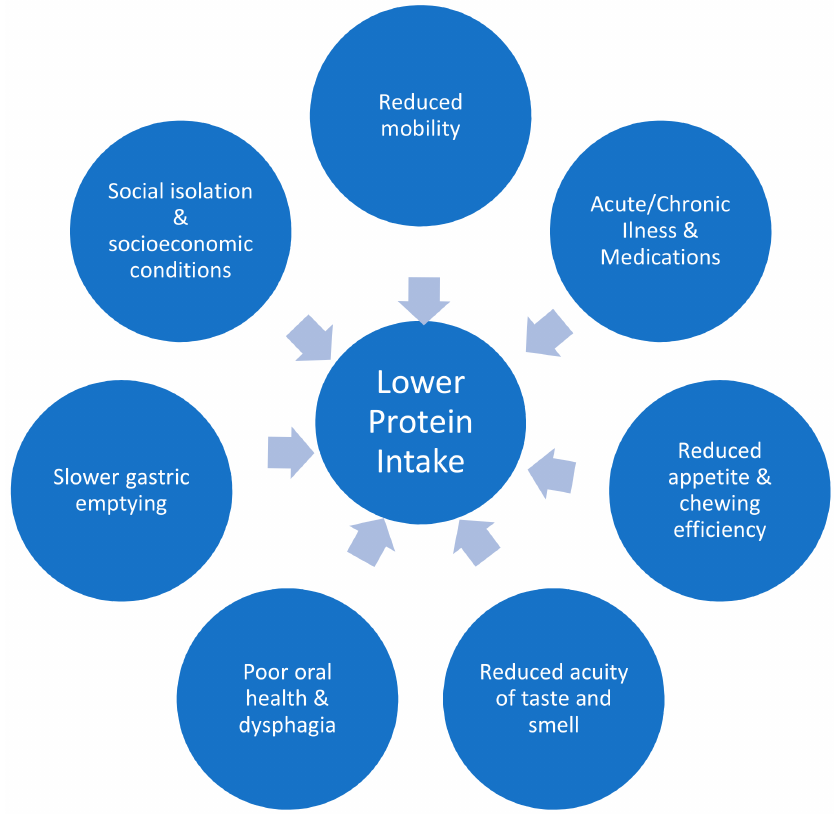
Figure 1. Factors leading to lower protein intake in older